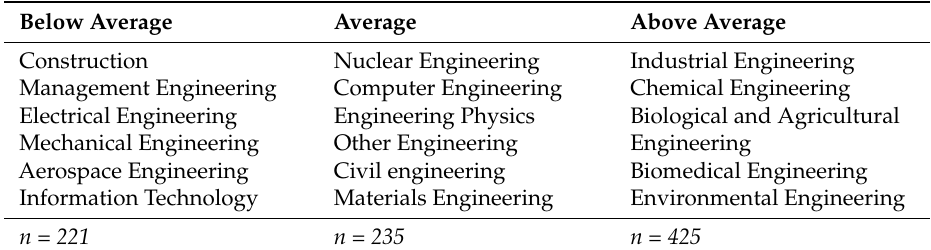
Table 2. Breakdown of Representation of Women in Engineering in the Sample. Below